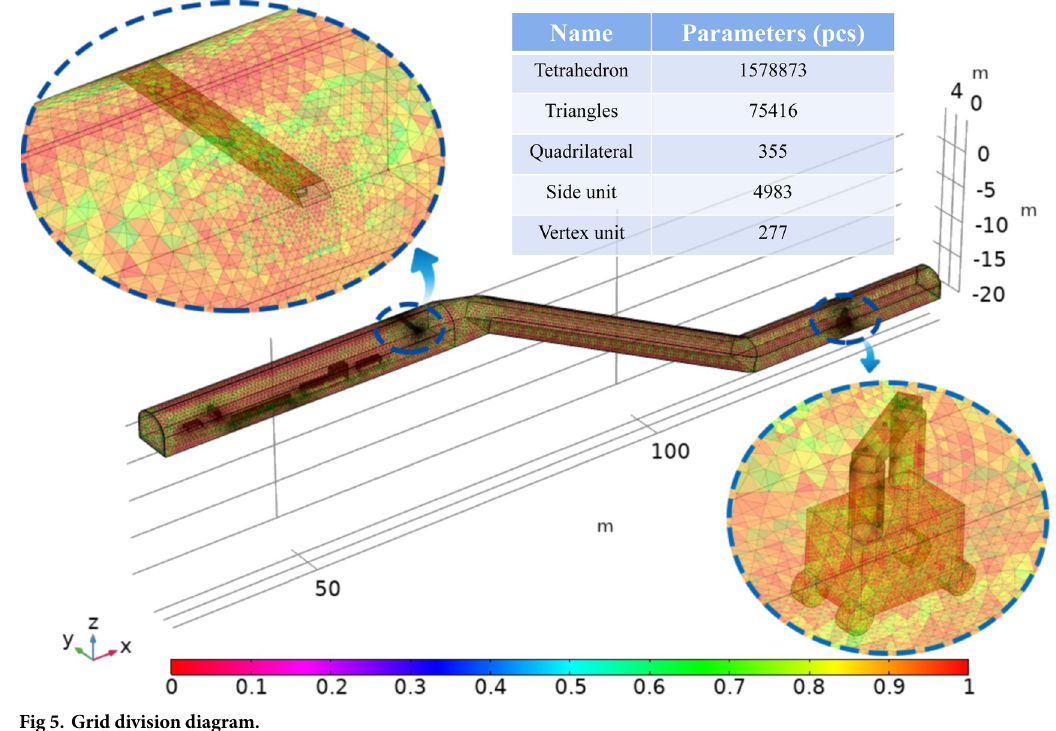
Fig 5. Grid division